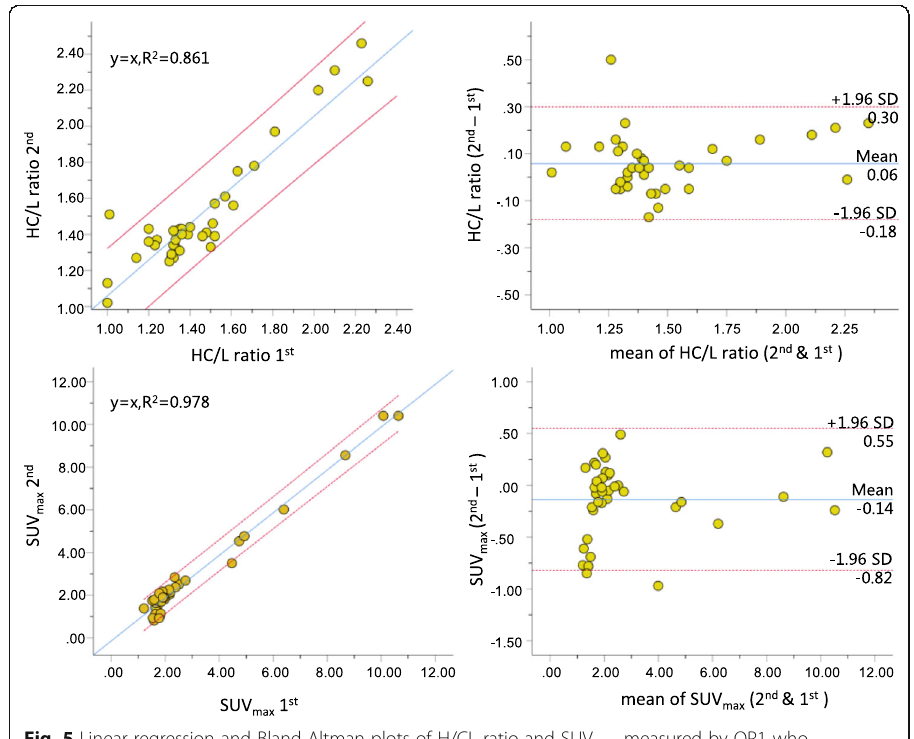
Fig. 5 Linear regression and Bland-Altman plots of H/CL ratio and SUV max measured by OP1 who processed the same image sets in 4 weeks